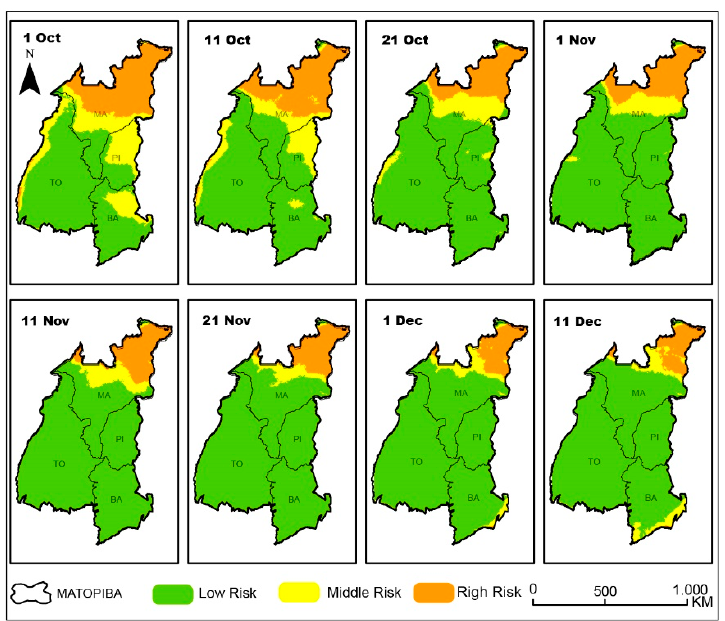
Figure 6. Agroclimatic risk of soybean culture in the MATOPIBA region for the unfavorable (dry) scenario.